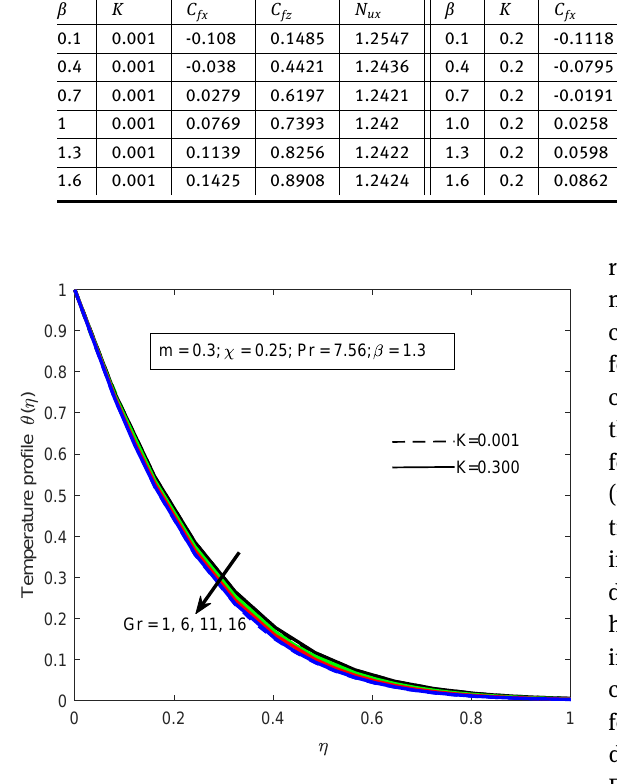
Figure 22: Variation of temperature profile with Grashof number